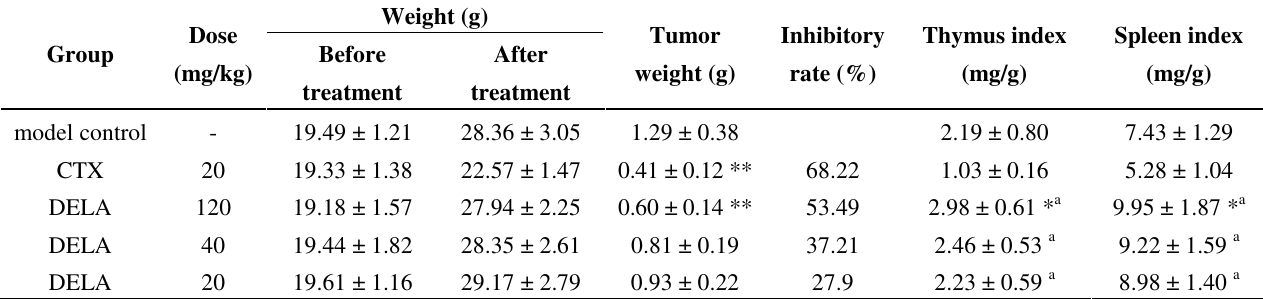
Table 1. Effects of DELA on S180 in Mice (Mean ± S.D.) ( n =